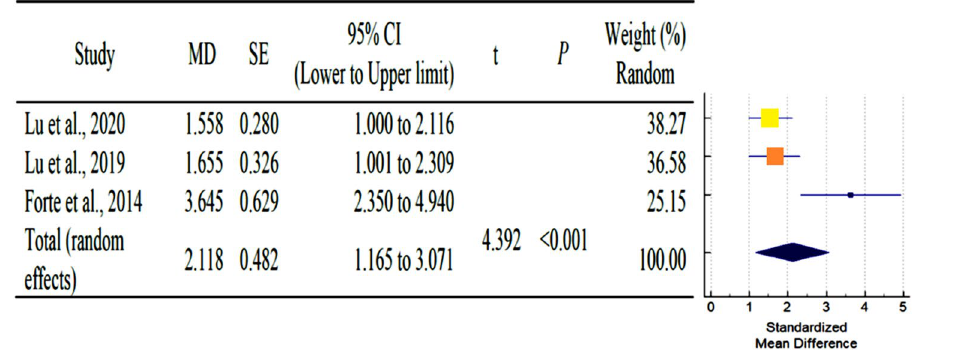
Figure 7. Forest plot for the outcome of N-S-PP.